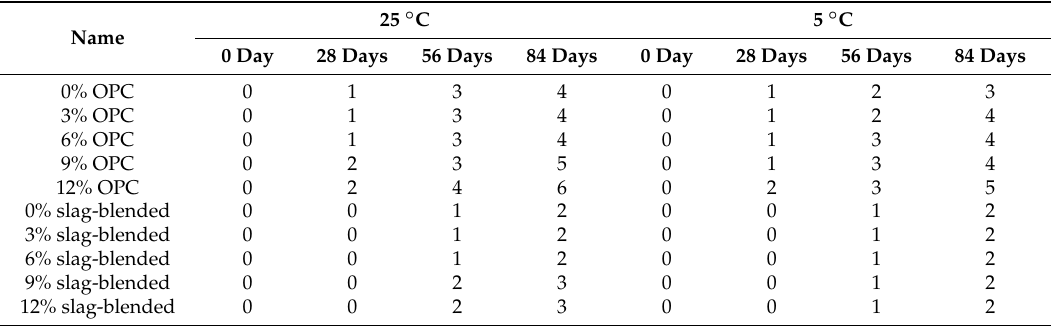
Figure 11. A representative view of cracks formed on the surface of 12% slag-blended mortars observed under a light microscope after 84 days of immersion in Na 2 SO 4 solution at 25 °C. Table 3. Damage rating in nano-TiO 2 containing OPC and slag-blended mortar specimens stored at 25 and 5 °C in Na 2 SO 4 solution.